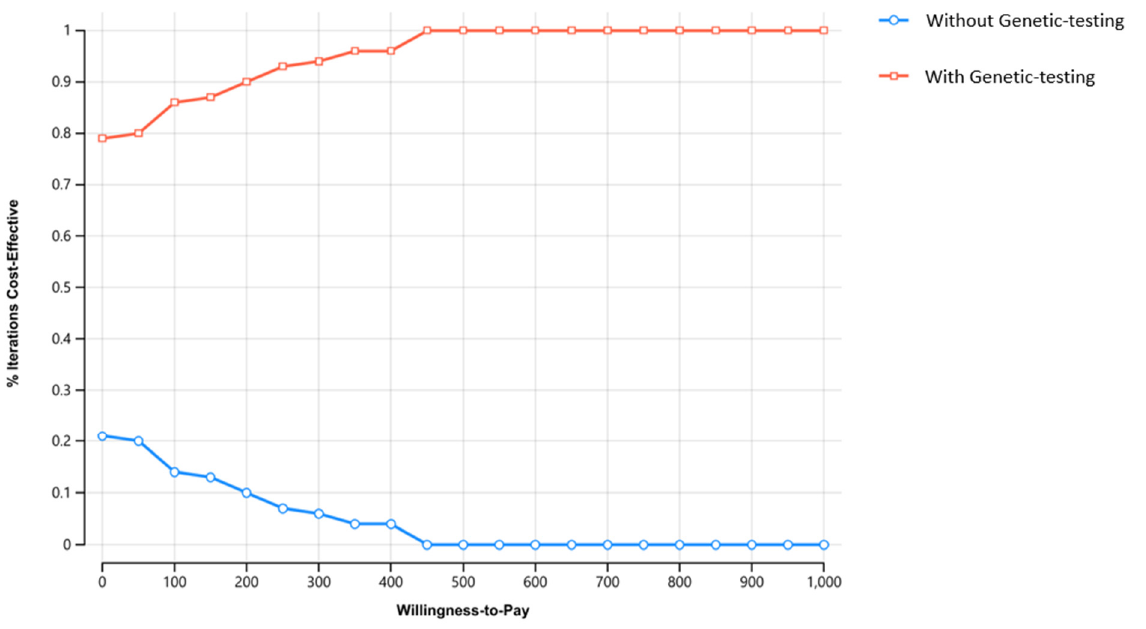
Figure 4. Cost effectiveness acceptability curve. The Y axis represent willingness-to-pay threshold ($ to QALY). The Y axis represents the precect of iteration. QALY: quality-adjusted life-year; WTP: willingness to pay.